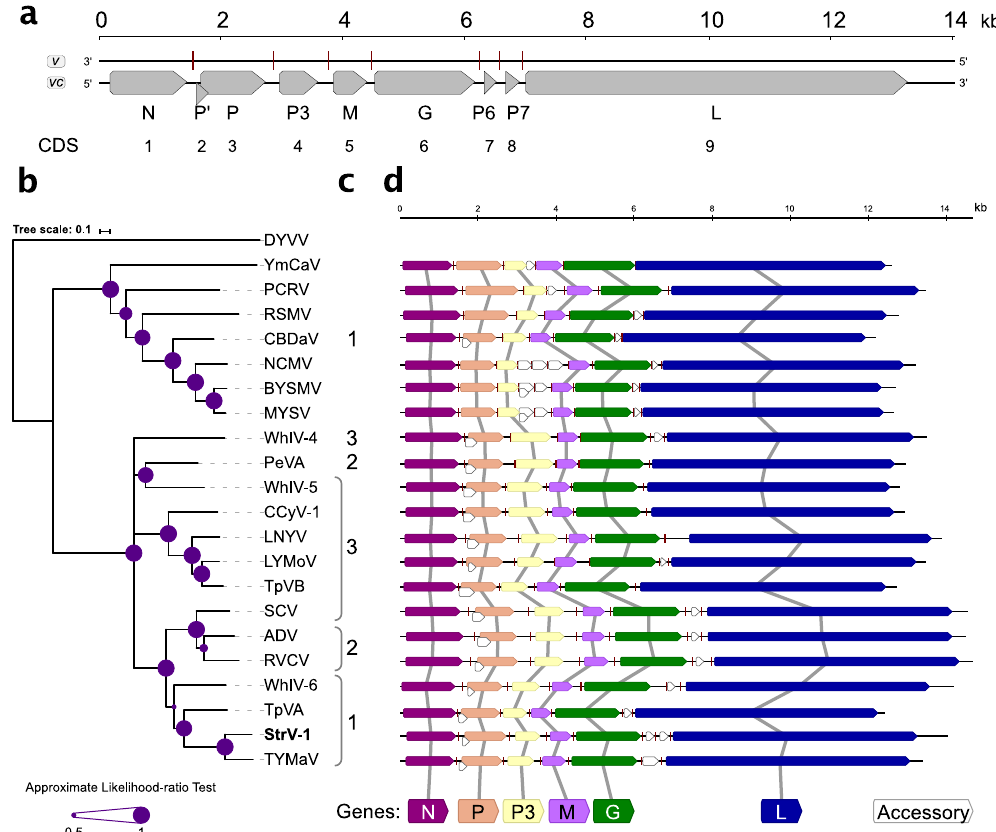
Figure 3. ( a ) Genomic organization of StrV-1- ˇCRM1, genotype A (MK211270). The nucleotide (nt) sequence is shown as a black line. Viral genomes and complementary strands are labelled as v and vc , respectively. Open reading frames (ORFs, or CDSs) are drawn as grey arrows, and putative regulatory regions are shown as red vertical lines. Segments are drawn to scale; ( b ) Phylogenetic tree based on L protein sequences of StrV-1 ˇCRM1 (B) and related cytorhabdoviruses. The acronyms are used as follows: alfalfa dwarf virus, ADV (NC_028237); barley yellow striate mosaic cytorhabdovirus, BYSMV (NC_028244); cabbage cytorhabdovirus 1, CCyV-1 (KY810772); colocasia bobone disease-associated virus, CBDaV (NC_034551); datura yellow vein nucleorhabdovirus, DYVV (NC_028231); lettuce necrotic yellows virus, LNYV (NC_007642); lettuce yellow mottle virus, LYMoV (NC_011532); maize yellow striate virus, MYSV (KY884303); northern cereal mosaic cytorhabdovirus, NCMV (NC_002251); papaya cytorhabdovirus, PCRV (KY366322); persimmon virus A, PeVA (NC_018381); raspberry vein chlorosis virus, RVCV (MK257717); rice stripe mosaic virus, RSMV (NC_040786); strawberry crinkle cytorhabdovirus, SCV (MH129615); tomato yellow mottle-associated virus, TYMaV (NC_034240); Trifolium pratense virus A, TpVA (MH982250); Trifolium pratense virus B, TpVB (MH982249); Wuhan Insect virus 4, WhIV-4 (NC_031225); Wuhan Insect virus 5, WhIV-5 (NC_031227); Wuhan Insect virus 6, WhIV-6 (NC_031232); yerba mate chlorosis-associated virus, YmCaV (KY366322). A plant-infecting nucleorhabdovirus, DYVV, was used as an outgroup. Scale bars refer to a phylogenetic distance expressed in amino acid substitutions per site. Support values are expressed graphically; ( c ) The number of predicted transmembrane domains (TM) in P’ proteins (when applicable); ( d ) Comparative genomic organization of StrV-1- ˇCRM1 (A) and other cytorhabdoviruses. Virus names are those from the phylogenetic tree. Shared gene synteny is shown with grey